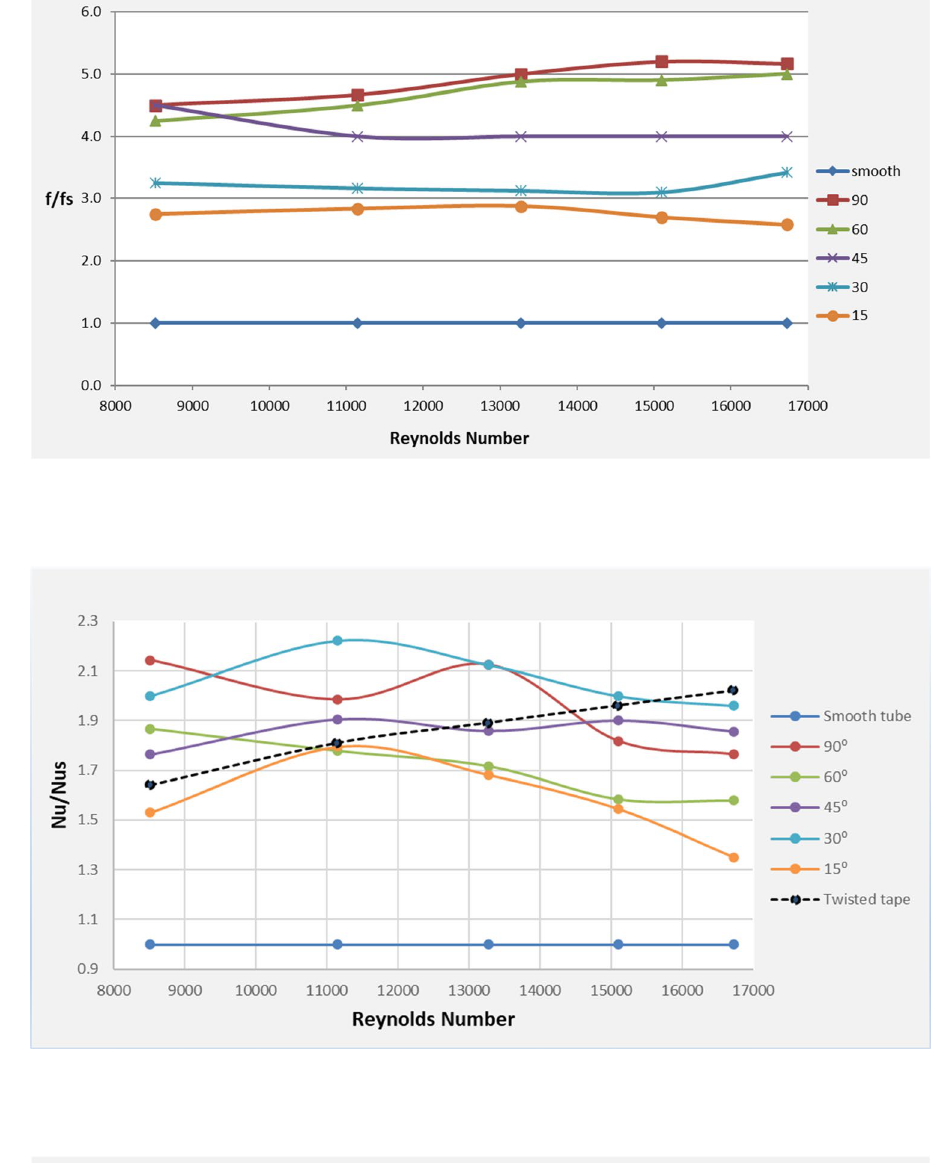
Fig. 12 Variation of Nu/Nus with Reynolds Number at P/D = 4 for MIs and Twisted